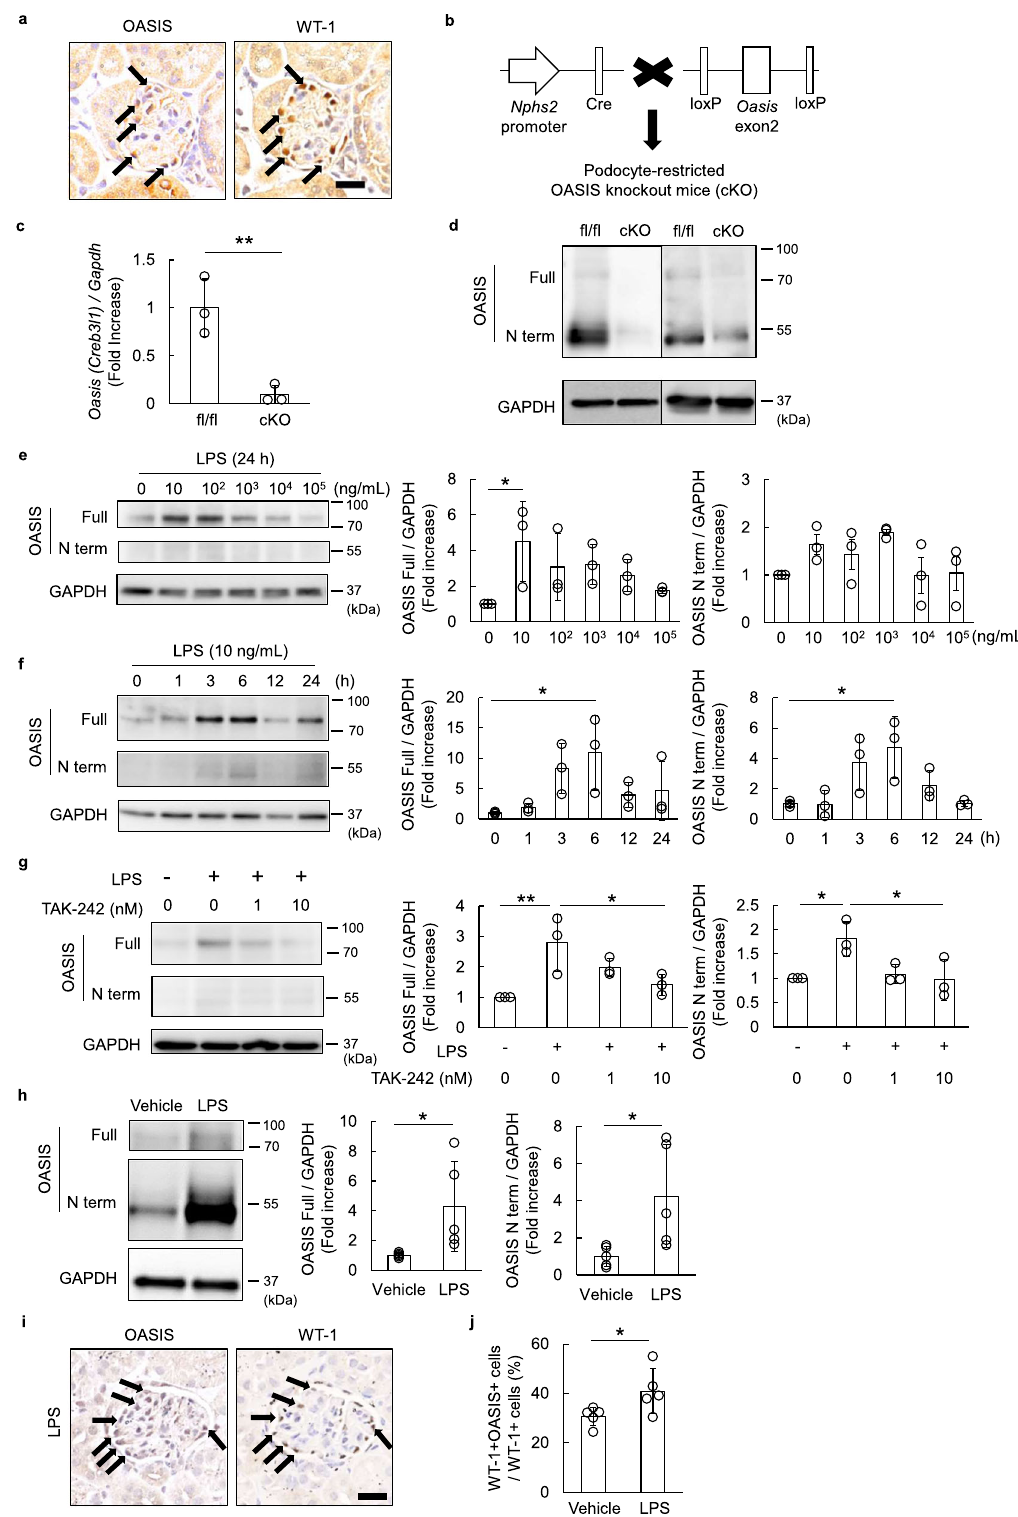
protein expression of OASIS increased in the glomeruli of the murine DN model (Fig. 4a). Next, the OASIS cKO and control mice were subjected to uninephrectomy, to accelerate the progression of kidney injury, followed by injection of STZ. We initially con fi rmed that STZ treatment blunted body weight gain, while increasing blood glucose level and urine volume, in both the OASIS cKO and control mice (Fig. 4b and Supplementary Fig. 3). Intriguingly, the